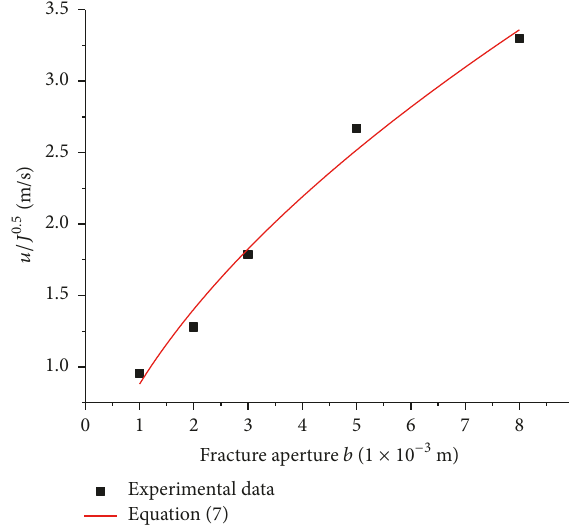
Figure 7: Relationship between 𝑢/𝐽 0.5 and aperture 𝑏 .